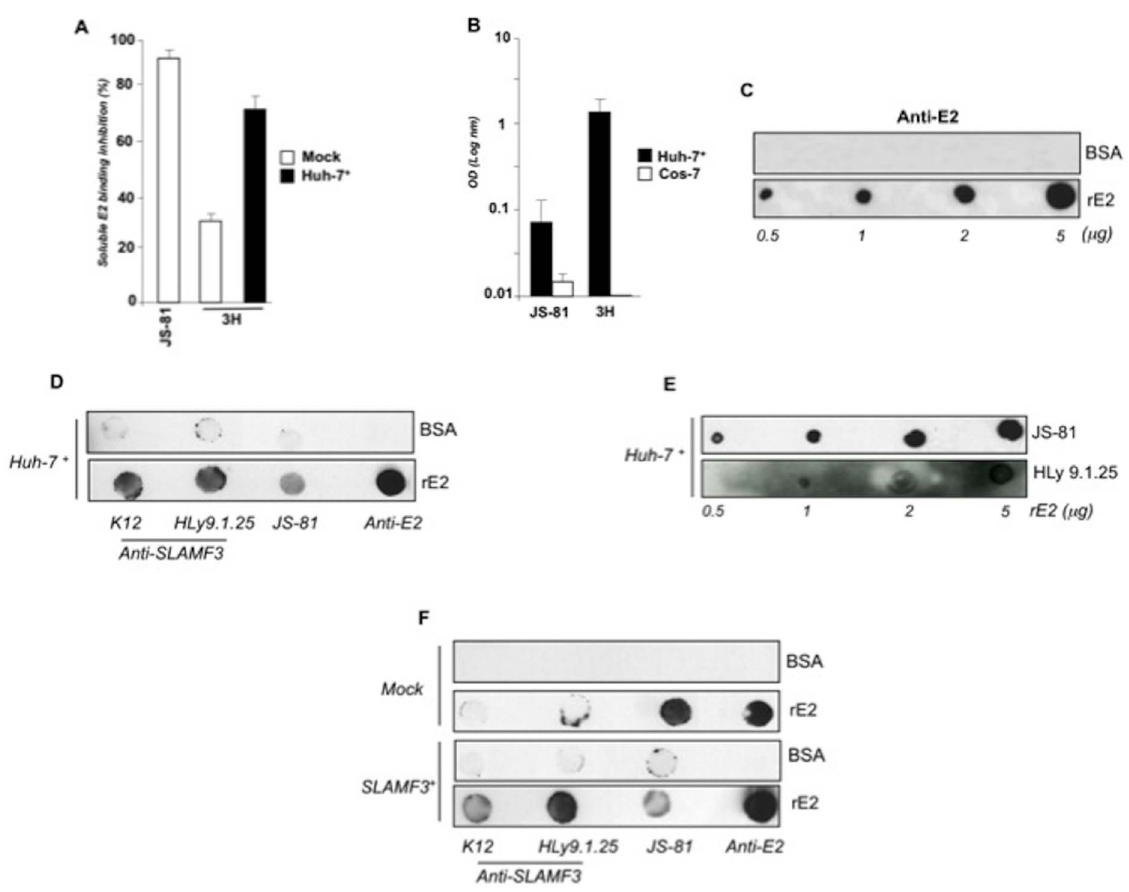
Figure 6. Recombinant viral E2 (rE2) interacts with SLAMF3. (A) Mock and Huh-7 + cells were fixed (in 4% PFA for 10 min) prior to incubation with rE2 for 1 h at 4 u C. To measure binding inhibition, cells were incubated with anti-CD81 (JS-81), anti-SLAMF3 (3H) or isotypes for 30 min prior to incubation with rE2 and detection of its binding with anti-E2 antibody by flow cytometry (the mean of two experiments; error bars: SD); (B) Extracted proteins from Huh-7 + and COS-7 were incubated with coated rE2 on an ELISA plate before extensive washing and specific detection of bound CD81 (JS-81) and SLAMF3 (3H) proteins. The optical density (OD) was read at 580 nm and is presented as the mean of two experiments; error bars: SD; (C) Recombinant soluble HCV E2 (rE2) and bovine serum albumin (BSA, used as a control) were coated on nitrocellulose membranes (at the indicated concentrations) prior to incubation with 3/11 E2-specific antibody; (D) rE2 and BSA (5 m g) were coated on nitrocellulose membranes and then incubated with proteins from Huh-7 + cells. Spots were detected using anti-E2 (positive control), anti-SLAMF3 (K12 and HLy9.1.25) and anti-CD81 (JS- 81) antibodies; (E) CD81 and SLAMF3 bound to rE2 used at the indicated concentrations were incubated with anti-CD81 (JS-81) and anti-SLAMF3 (HLy9.1.25) antibodies; (F) proteins from native COS-7 cells (top; mock) or SLAMF3-over-expressing COS-7 cells (bottom) were incubated with rE2 and BSA coated on nitrocellulose membranes prior to CD81 and SLAMF3 detection with specific antibodies. One representative experiment from three independent experiments is presented in A, D, E and F.